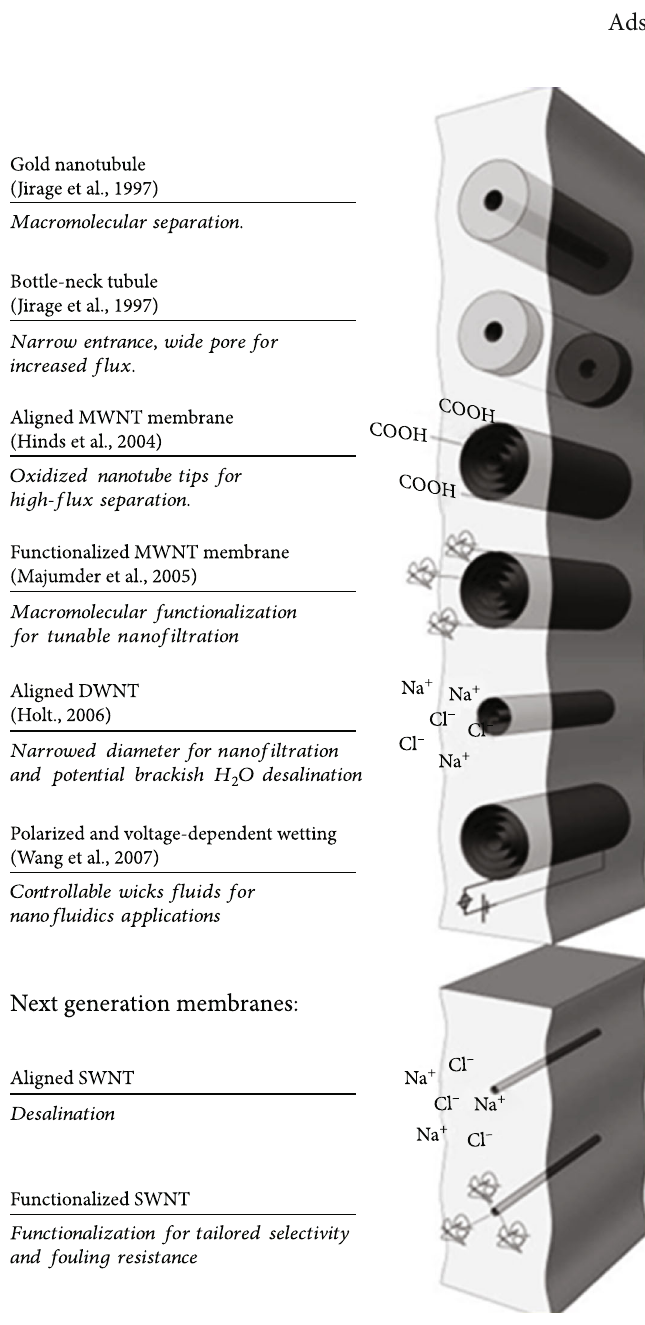
Figure 2: Aligned nanotube membrane development for chemical separation and water